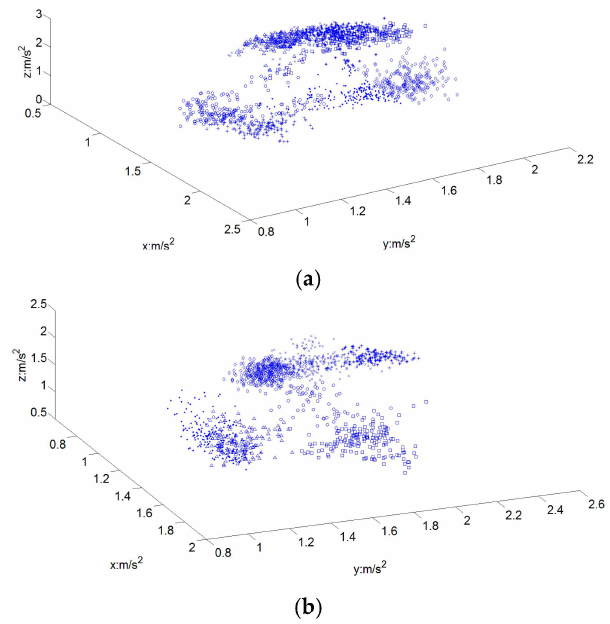
Figure 7. Distributions of the ACC mean values of dominant hand. ( a ) Distribution of one-handed subwords; ( b ) Distribution of two-handed